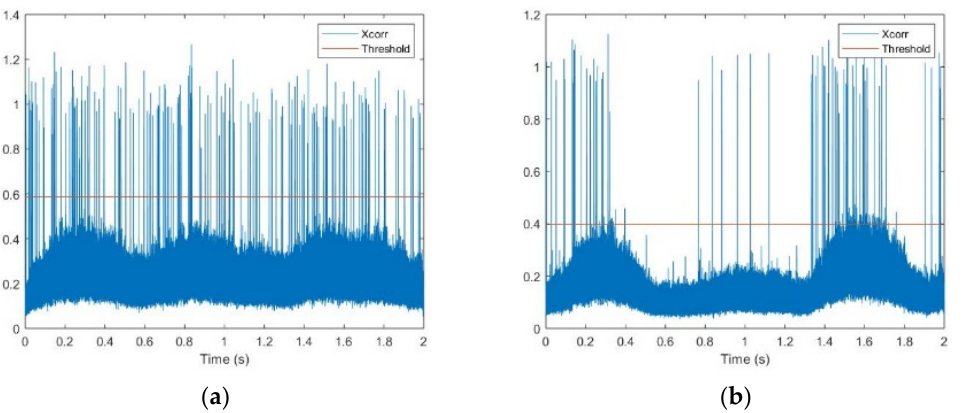
Figure 14. ( a ) PS cross-correlation values over a time-interval before first SIC loop; ( b ) PS cross- correlation values over a time-interval before second SIC loop.